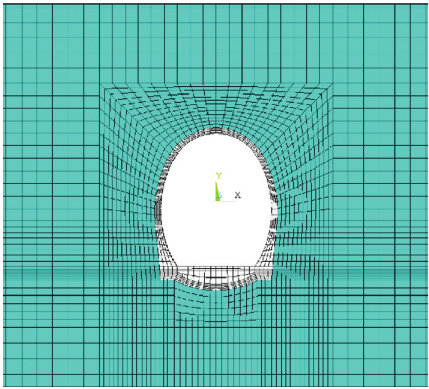
Figure 6: Computational model.